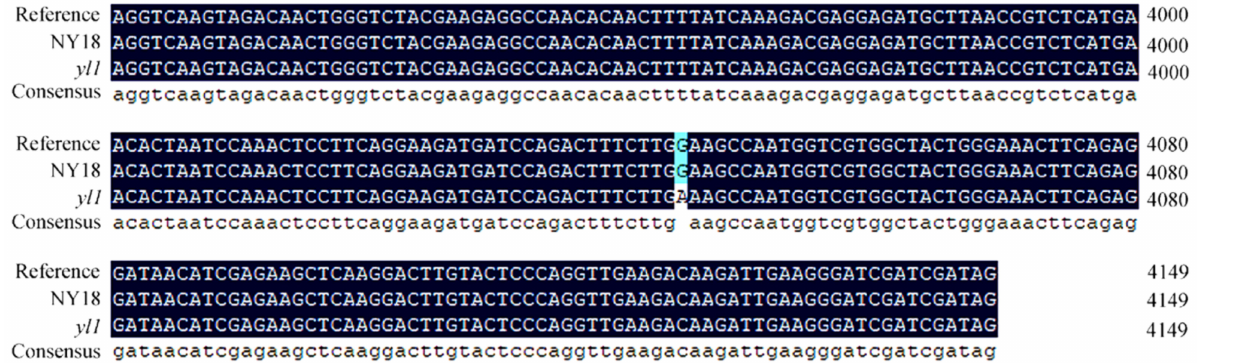
Figure 5. Sequence alignment of the coding sequence of BnaA03G0054400ZS gene between NY18 and yl1 . There was a base substitution (G to A) at 4045 bp of the CDS in the fifth exon in yl1